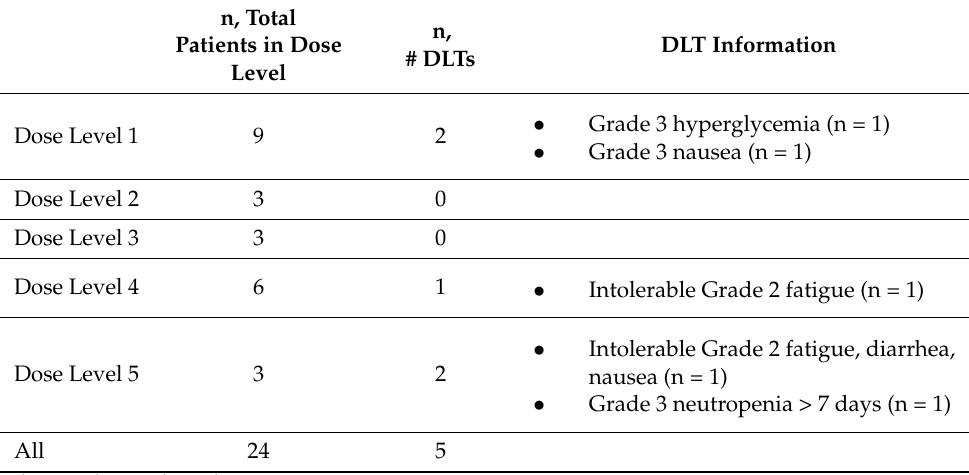
Table 2. Dose-limiting toxicities by dose level. n,